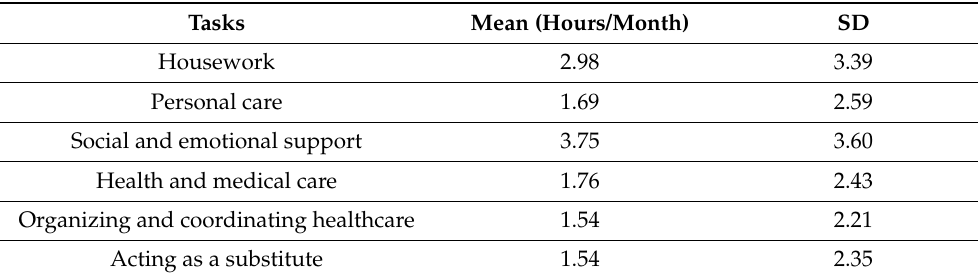
Table 3. The average hours spent per month on informal caregiving tasks for the participants in this